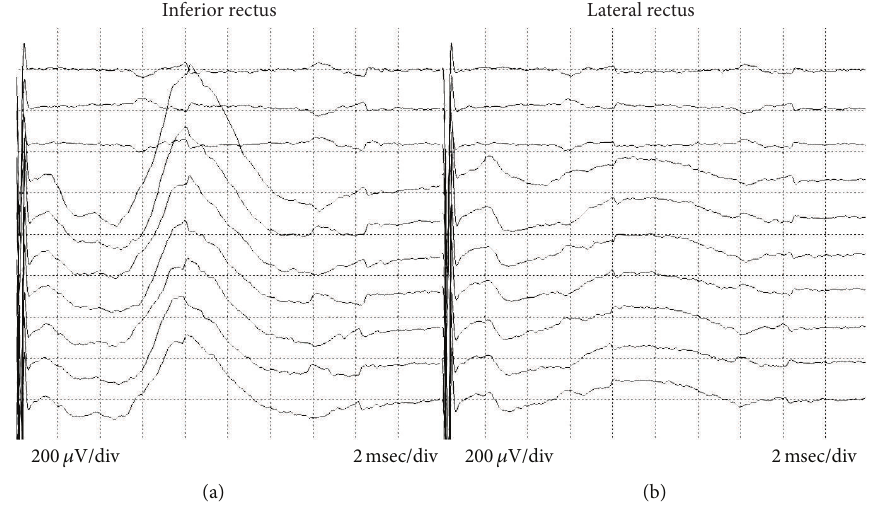
Figure 4: Monopolar stimulation of the left oculomotor nerve at 0.50 mA with subsequent compound muscle action potentials recorded from the left inferior rectus muscle using and intramuscular needle electrode (a). This response is referenced to the contralateral orbicularis oculi muscle. (b) The ipsilateral lateral rectus recording, which was not activated with this